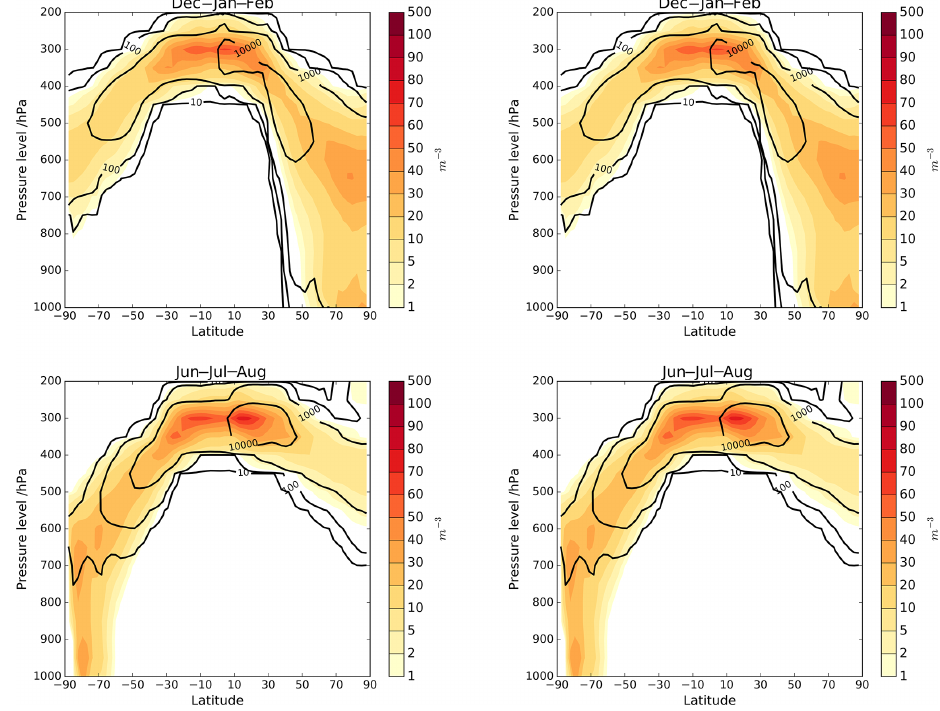
Figure 6. Zonal mean profiles of [INP] ambient for every month of the year. The black contour lines correspond to the INP concentration of K-feldspar aerosols (m − 3 ), while the colour map shows the INP concentration of marine organic aerosol The values correspond to seasonal mean values calculated using daily concentrations and temperatures and averaged across latitudes.